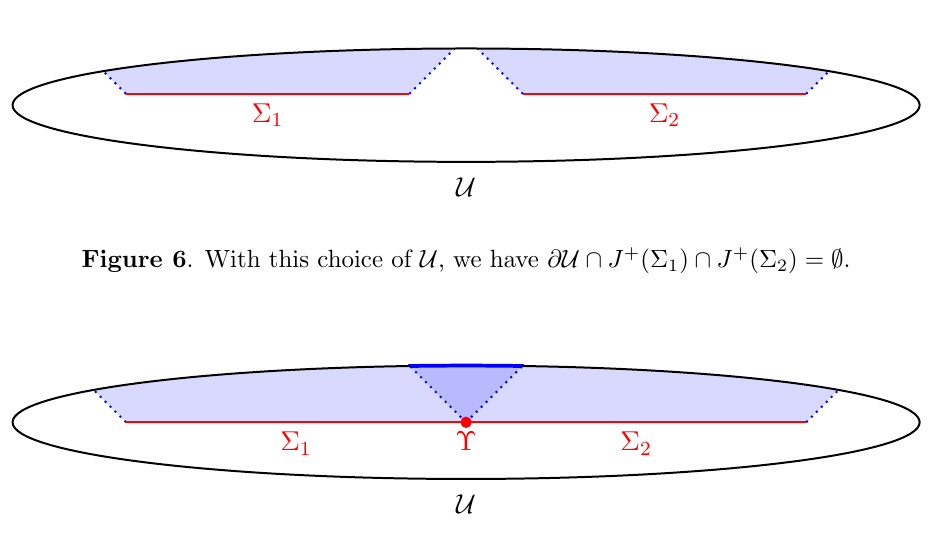
Figure 7 . When there is no gap, it is not possible to choose U such that @ U \ J + ((cid:6) 1 ) \ J + ((cid:6) 2 ) = ; . The red dot denotes the edge (cid:7) joining (cid:6) 1 and (cid:6) 2 , commonly known as the entangling